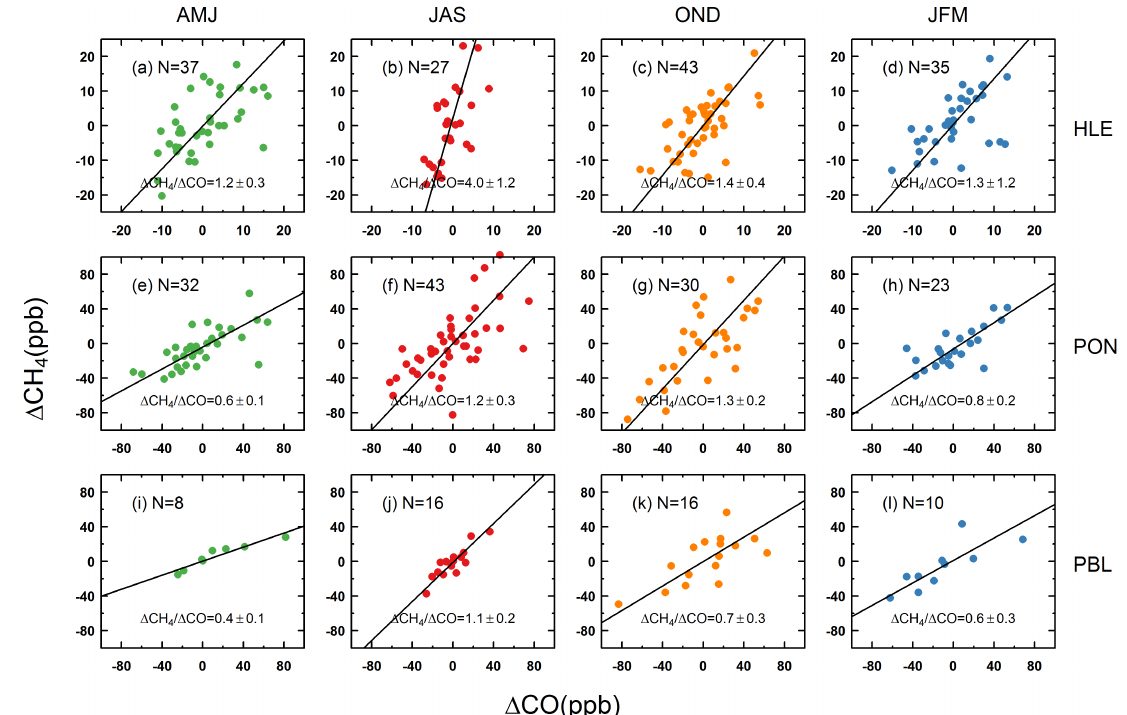
Figure 14. The relationships between (cid:49) CH 4 and (cid:49) CO at HLE (a–d) , PON (e–h) , and PBL (i–l) for April–June (AMJ), July–September (JAS), October–December (OND), and January–March (JFM). For each panel, (cid:49) CH 4 and (cid:49) CO are estimated as residuals from smoothed curves. The (cid:49) CH 4 /(cid:49) CO ratio is the slope of the fitting line from the orthogonal distance regression, with the SD calculated from 1000 bootstrap